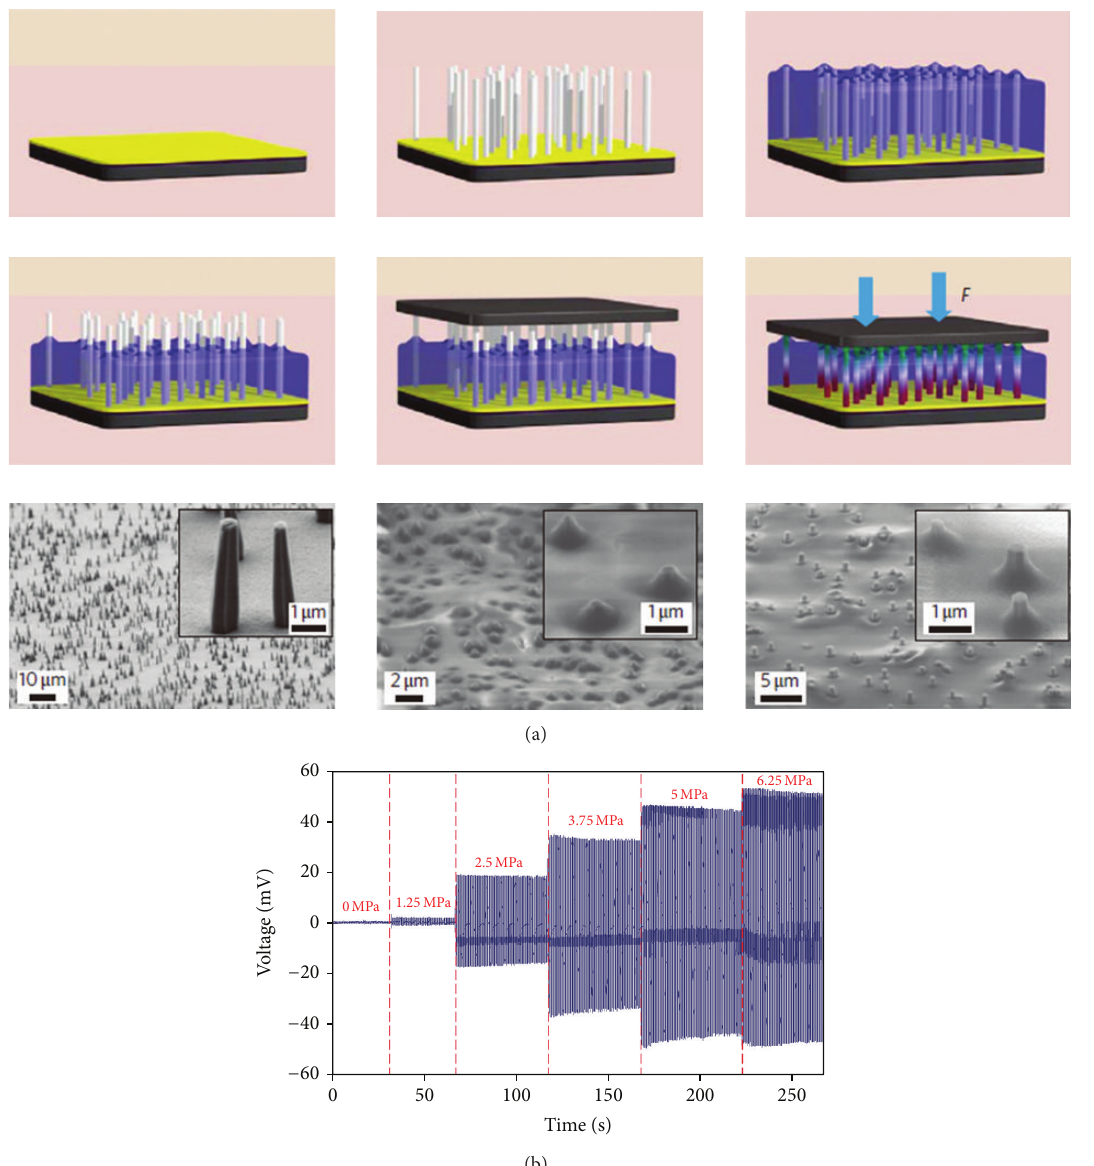
Figure5:(a)SchematicdiagramofthefabricationprocessoftheVING.(b)TheoutputvoltageoftheVINGunderdifferentexternalpressures. [Reproduced from [22] with the permission from Nature Publishing